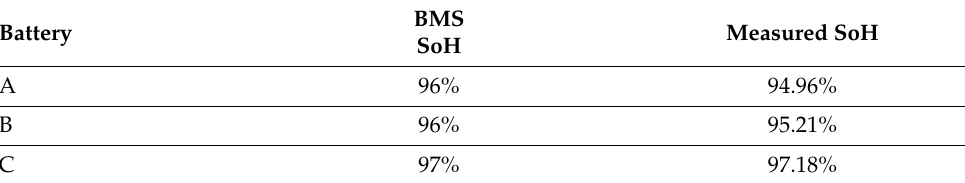
Table 4. Measured states of health of the